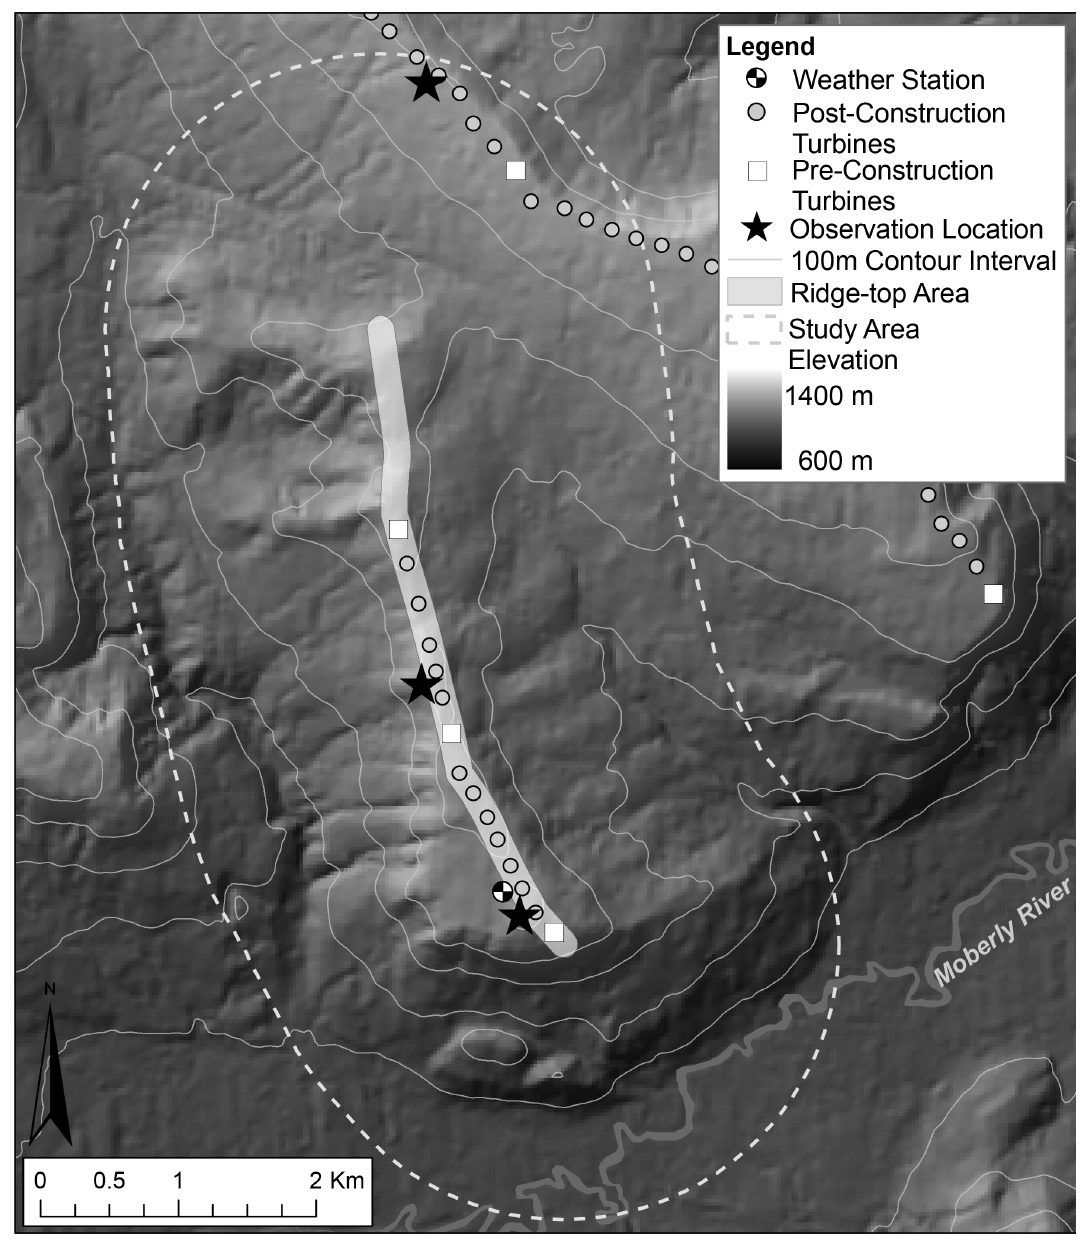
Figure 1. Study site. Site map of the Dokie 1 Wind Energy Project in the Peace River Regional District of northeast British Columbia, Canada (55 u 46 9 28 0 N, 122 u 16 9 49 0 W).